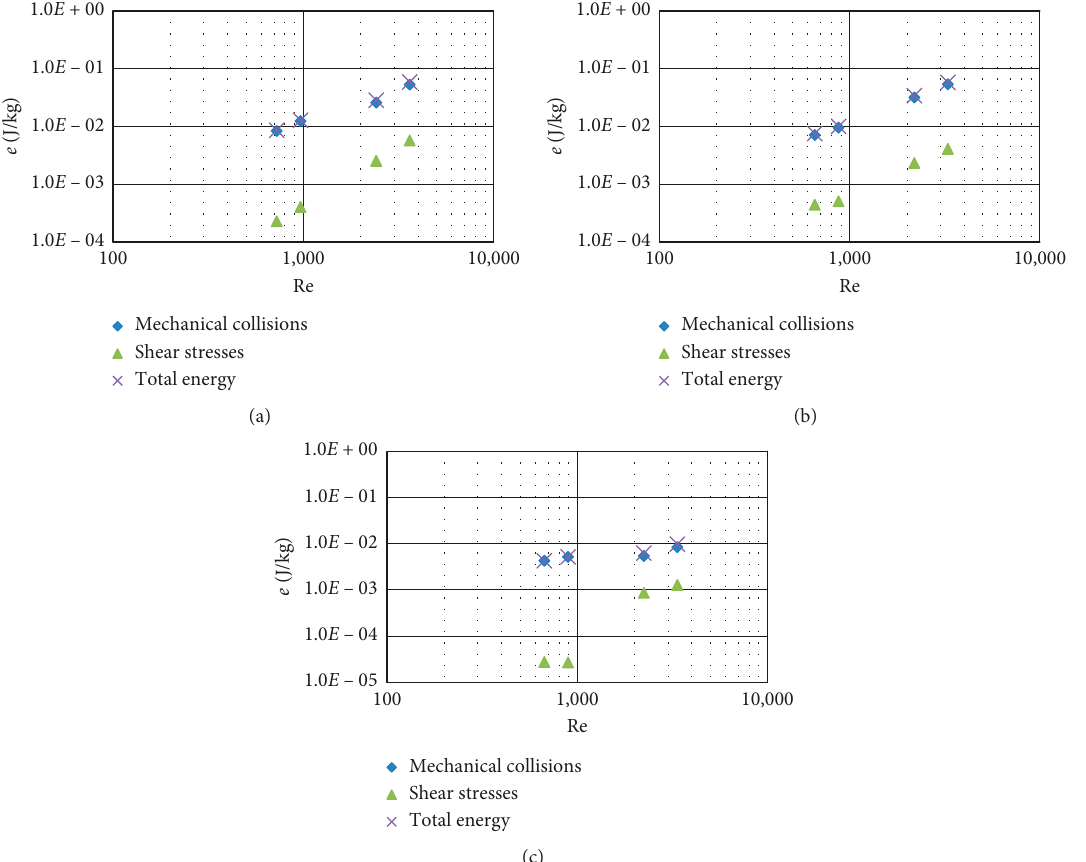
e pipe ~Re 0.4392 R 2 = 0.8949